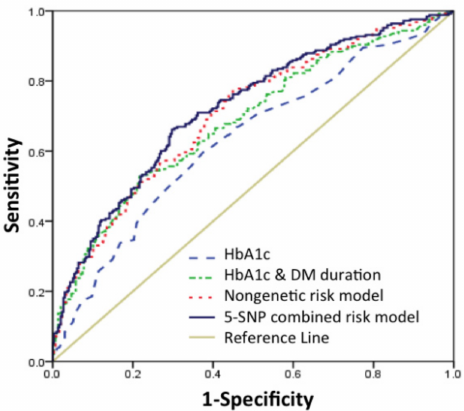
Figure 5. Receiver operating characteristic (ROC) curves and area under the curve (AUC) in diabetic patients. Blue line: HbA1c risk score (AUC = 0.631); green line: HbA1c and DM duration risk model (AUC = 0.685); red line: nongenetic risk model (AUC = 0.704); navy line: 5-SNP combined risk model (AUC = 0.722). The beige line represents the reference line (no discrimination).